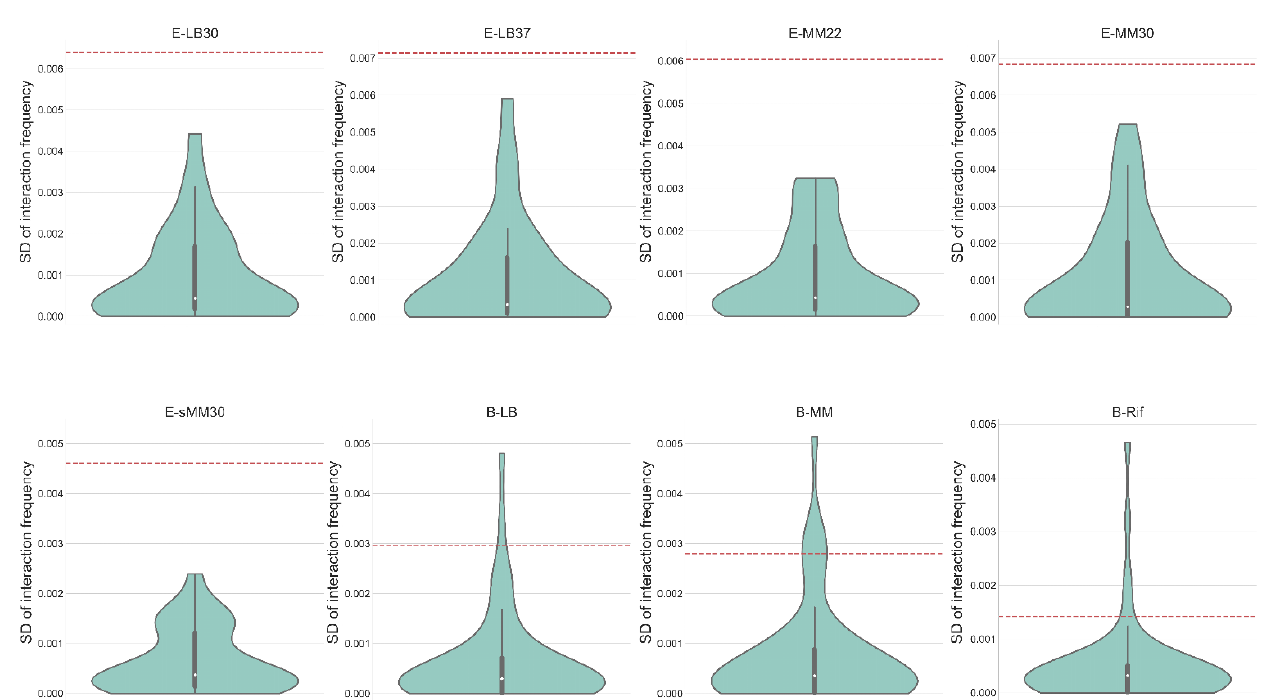
Figure 4. Comparison of chromatin interaction frequencies of FFL edges with TRN. In almost all cases, the chromatin interaction frequency between X and Y/Z in the feed-forward loop is significantly lower than TRN, while the interaction frequency between Y and Z is significantly higher than TRN. Significance level: p < 0.05.